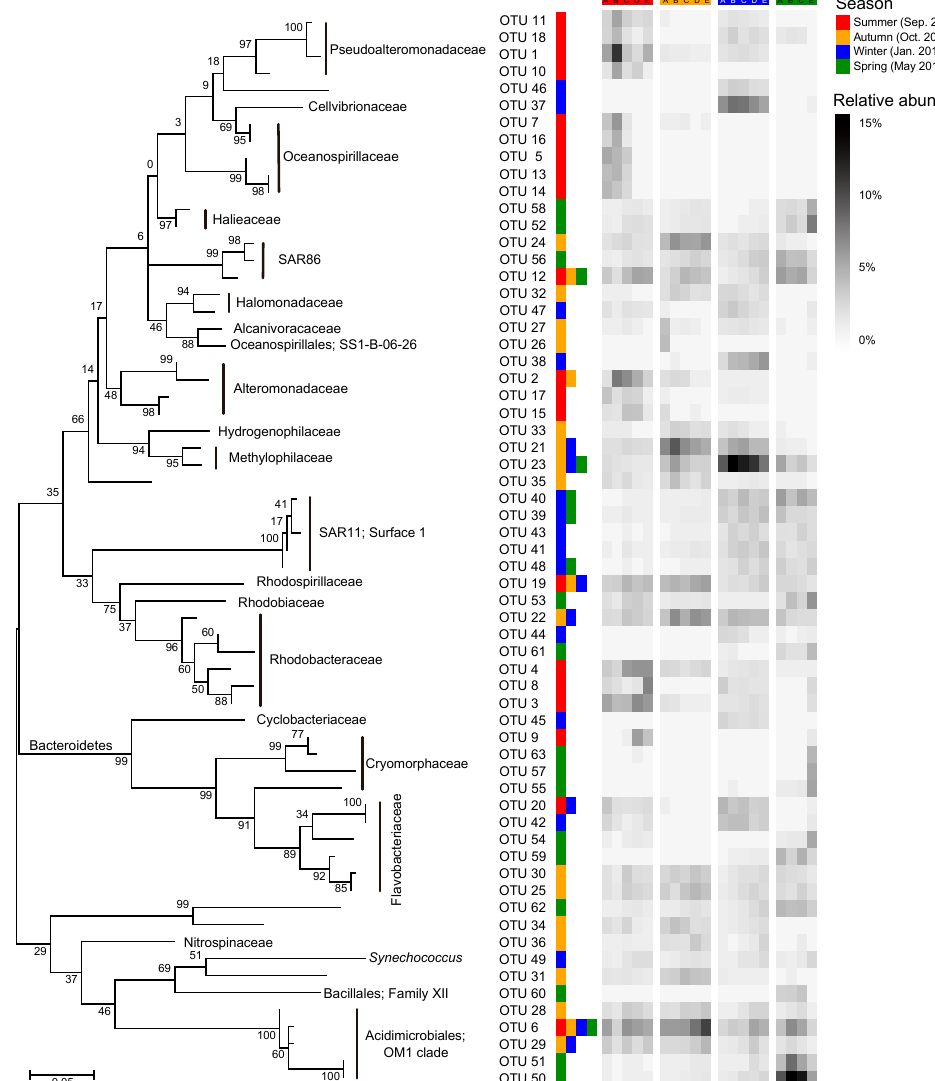
Figure 7. Dynamics of key bacterial OTUs (operational taxonomic units) dominantly responsible for spatial turnover of bacterial community composition across sites over seasons. The heatmap shows average relative abundance of the top 20 OTUs contributing the most compositional variation of bacterial communities along the gradient in each season as identified by Similarity percentage analysis (SIMPER; see detailed results of SIMPER in Dataset S2). The color keys following a given OTU indicate that the OTU was a key driver of spatial turnover in specific season(s). The phylogenetic tree was constructed using MEGA 7.0 with the maximum likelihood method.